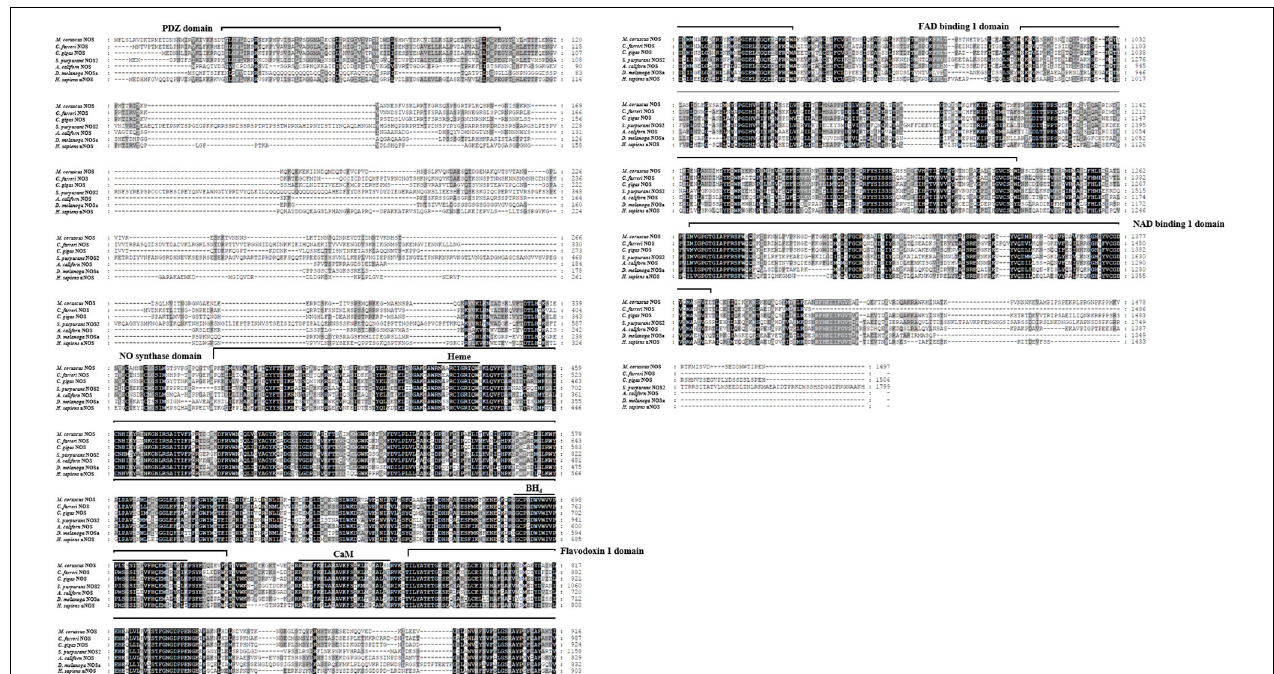
FIGURE 4 | Multiple sequence alignment of amino acid sequences of NOS and other NOSs deposited in GenBank. Nitric oxide synthases from different species and their GenBank accession numbers are as follows: C. farreri NOS (AGI44587.1), C. gigas NOS (EKC33784.1), S. purpuratus NOS2 (XP_011665136.1), A. californica NOS (NP_001191470.1), D. melanogaster NOSa (NP_523541.2), and H. sapiens nNOS (AAA62405.1). Different domains and binding sites based on homology with H. sapiens nNOS are